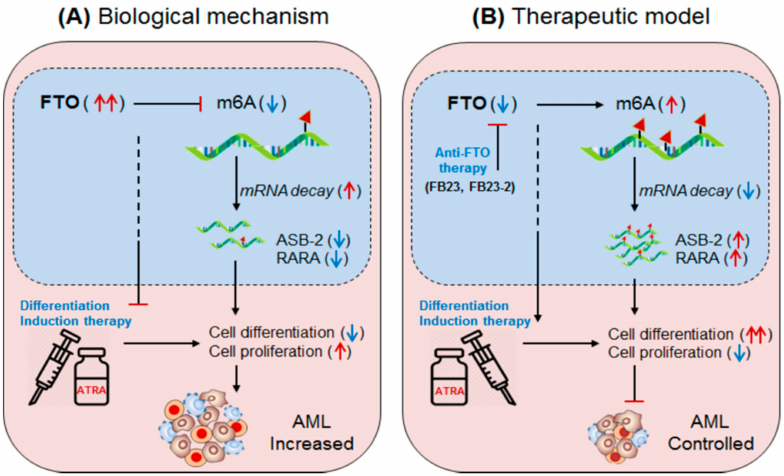
Figure 3. Therapeutic model targeting intracellular m6A-eraser protein FTO in controlling AML. ( A ) Biological mechanism: The m6A-demethylase FTO is abnormally expressed in APL and